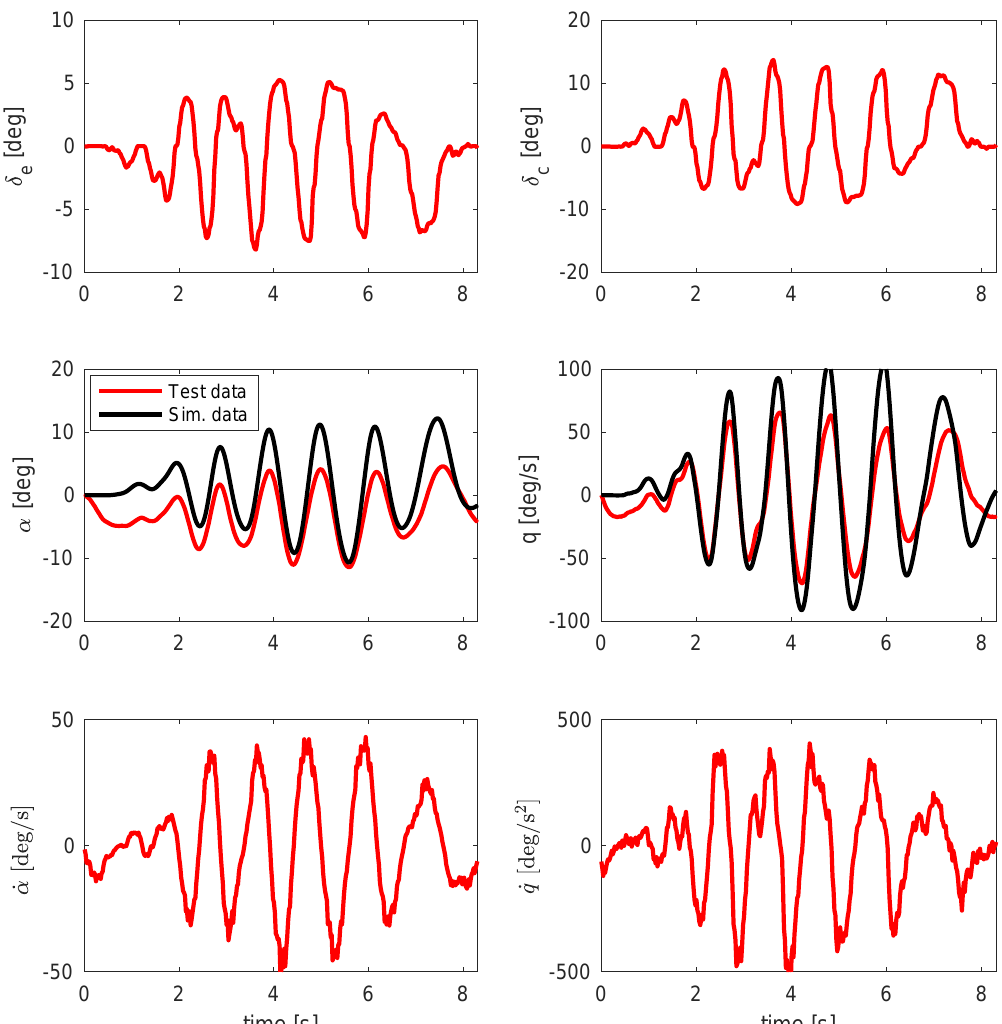
Figure 5. Validation data from earlier flight tests. Test data are shown in red, while simulated model data are shown in black for the states angle-of-attack and pitch rate.